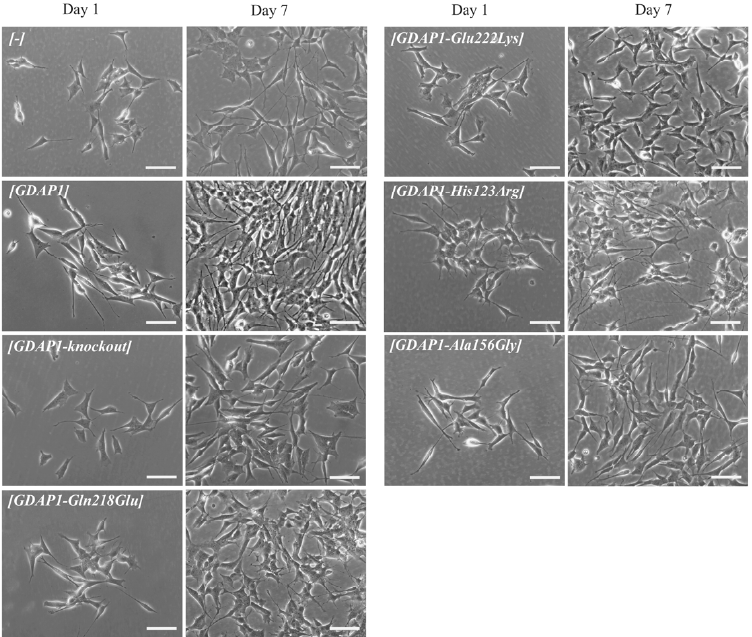
Figure 4. The expression of p.Glu222Lys results in a marked reduction of neurites-like projections formation. The SH-SY5Y cells with a knockout of GDAP1 or transfected with indicated GDAP1 alleles were visualized under light microscopy Zeiss Axio Imager at 24 (Day 1) and 168 (Day 7) hours after cells seeding. Scale bar = 100 μ m.